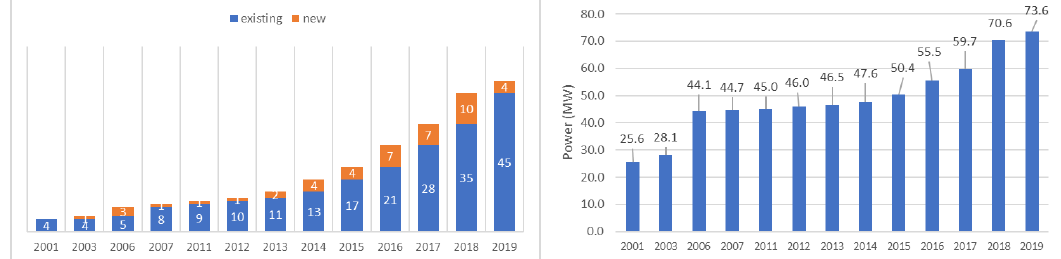
Figure 1. Evolution of the number of biogas plants and amount of installed power in Greece [21].